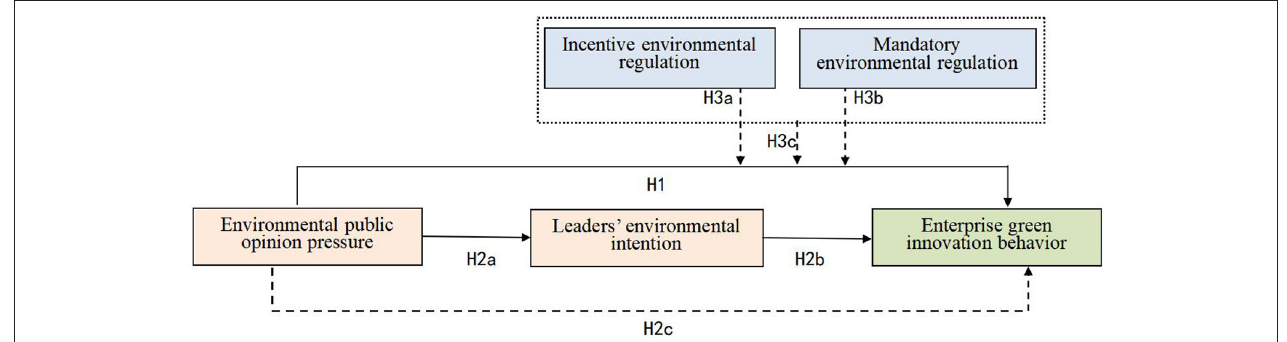
FIGURE 1 | Theoretical